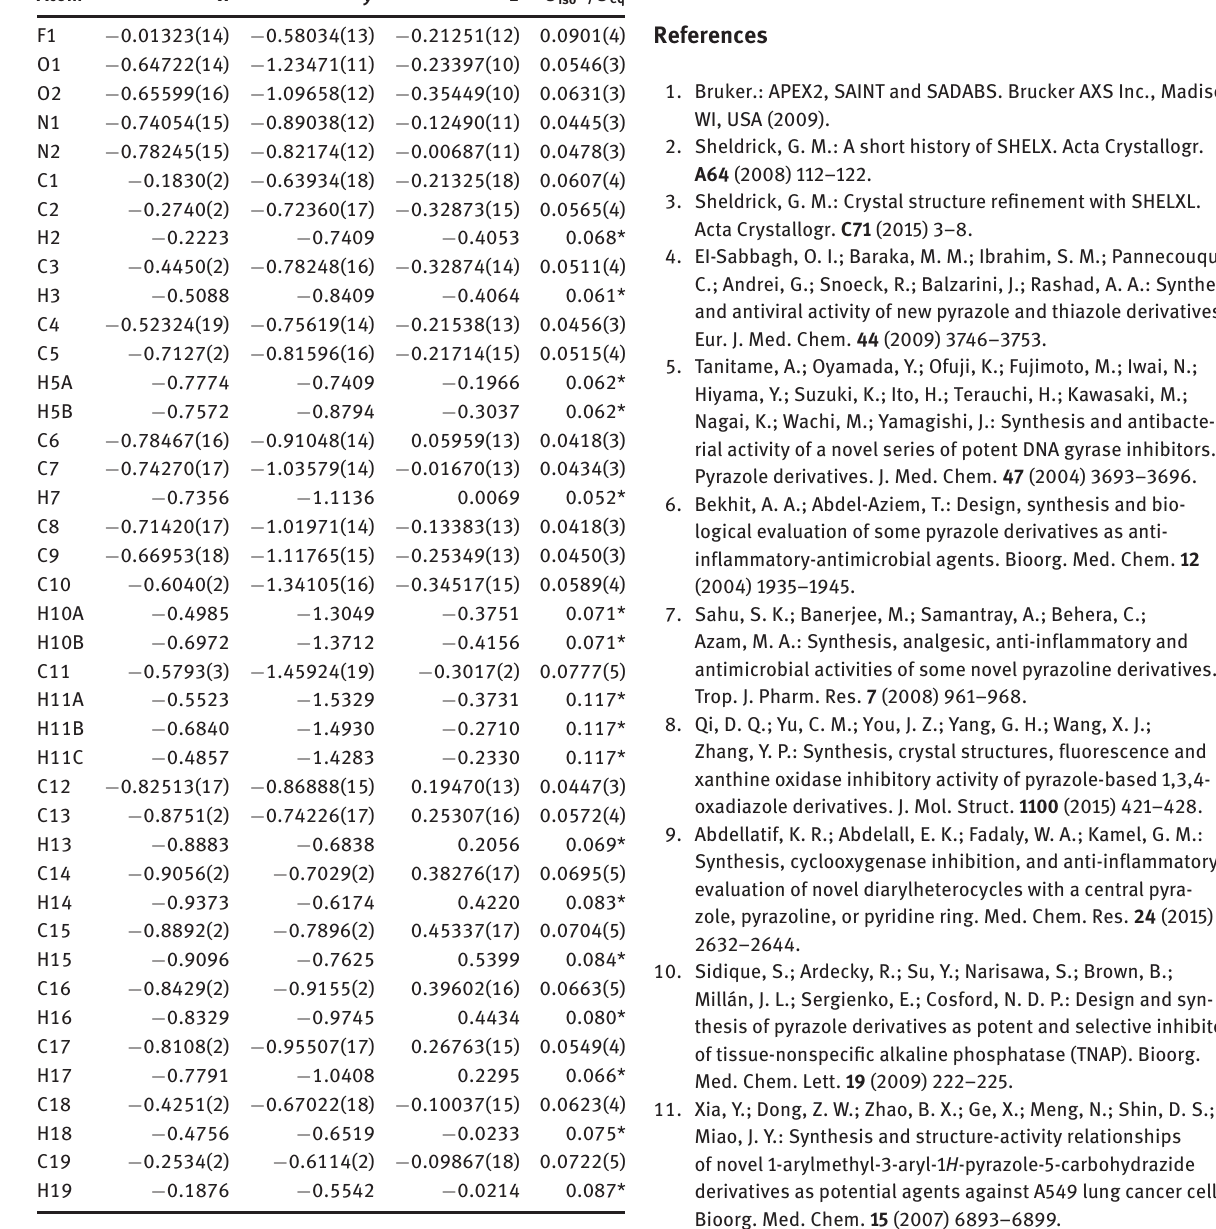
aryl moiety (C12/C13/C14/C15/C16/C17) is 81.9°. The two aryl moieties are twisted by an angle of